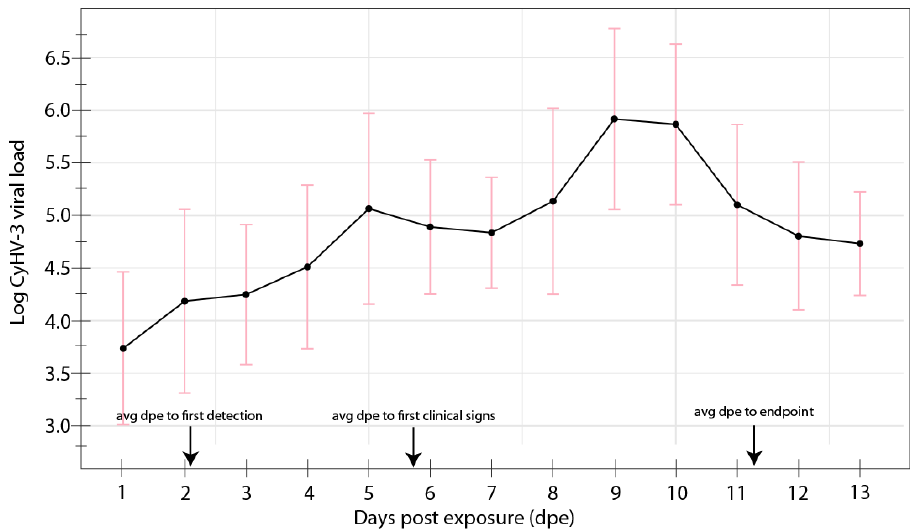
Figure 3. Trial 1 log CyHV-3 copy numbers. Average CyHV-3 viral loads for each day are denoted by points and standard deviations are denoted by pink bars. Average days to first detection of CyHV-3 in gill swabs, to first observation of disease signs and experimental endpoint are denoted with black arrows.